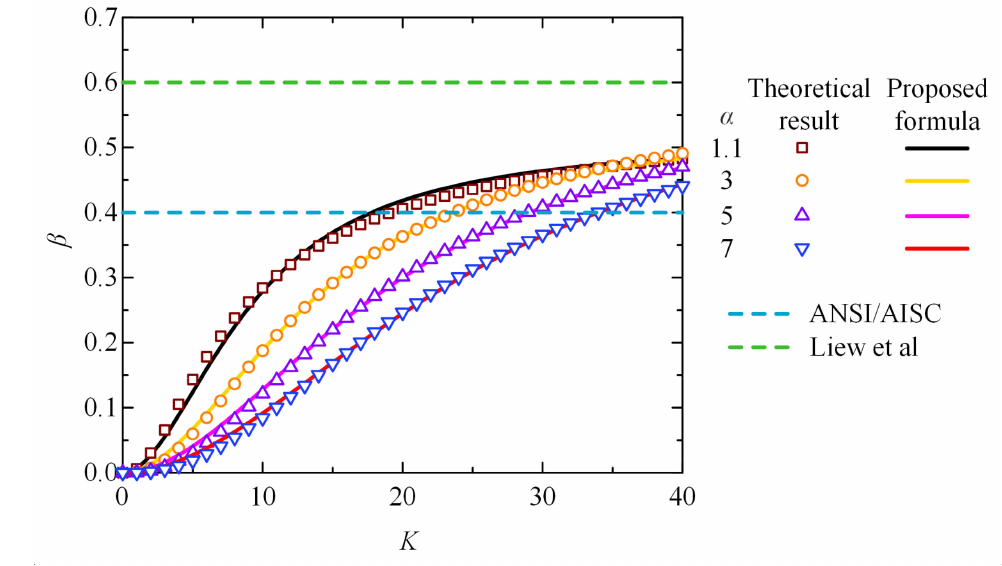
Figure 7. Variation in the weight factor of equivalent stiffness with end rotational restraint